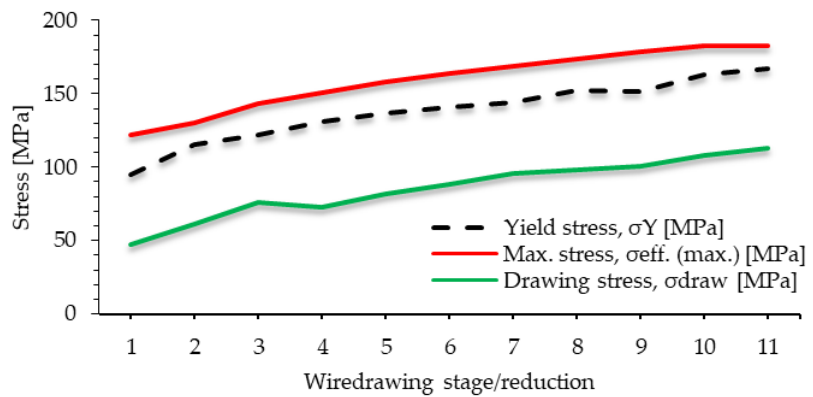
Figure 9. Evolution of main stresses during the multi-step wiredrawing process (stress mean values measured graphically in the simulations by “tracking point” option, with ±5% error tolerance).